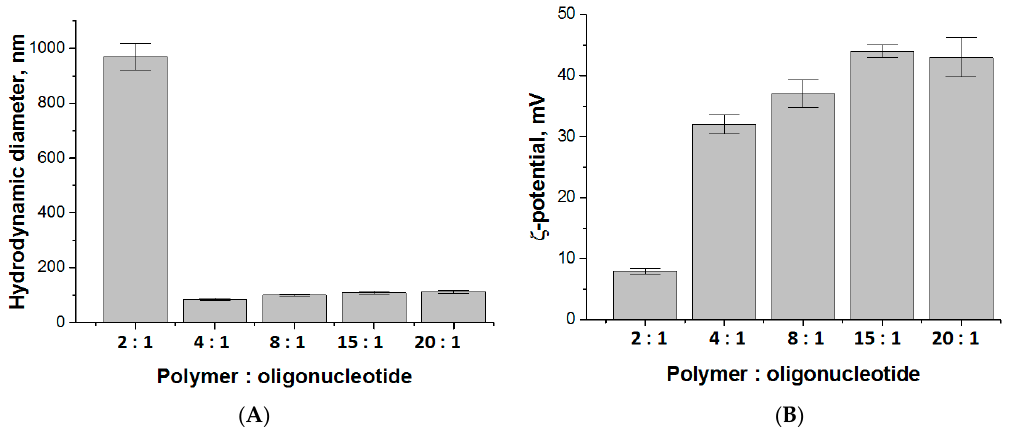
Figure 3. Hydrodynamic diameter ( A ) and surface charge ( B ) of polypeptide nanoparticles (sample KEI2), loaded with duplex oligo-dT-dA.